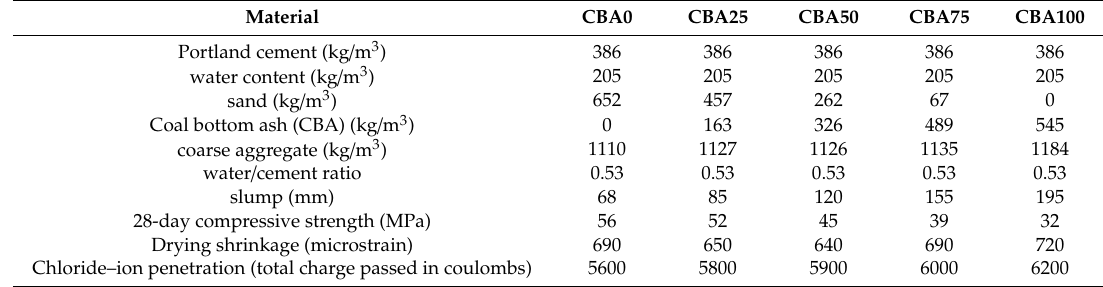
Table 2. Mixture with a fixed water / cement ratio (MIX-fixed-W / C): Concrete mixture design with a fixed water-cement ratio of 0.53 and the concrete’s properties (based on